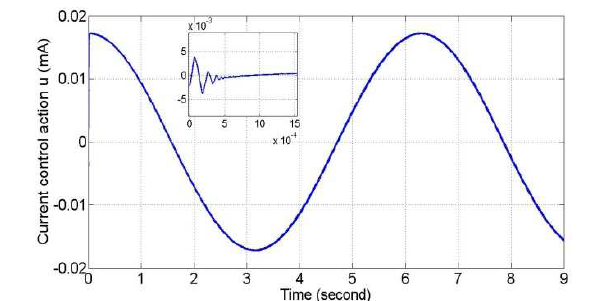
Fig. 21. Current control input under parametric uncertainties with desired sinusoidal